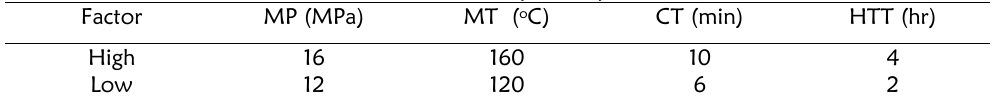
Figure 1: Reinforcement and friction modifier used (a) crushed coconut shells (b) seashells (c) commercial brake pad sample (d) extracted graphite rods Table 1: Factor level of process parameters